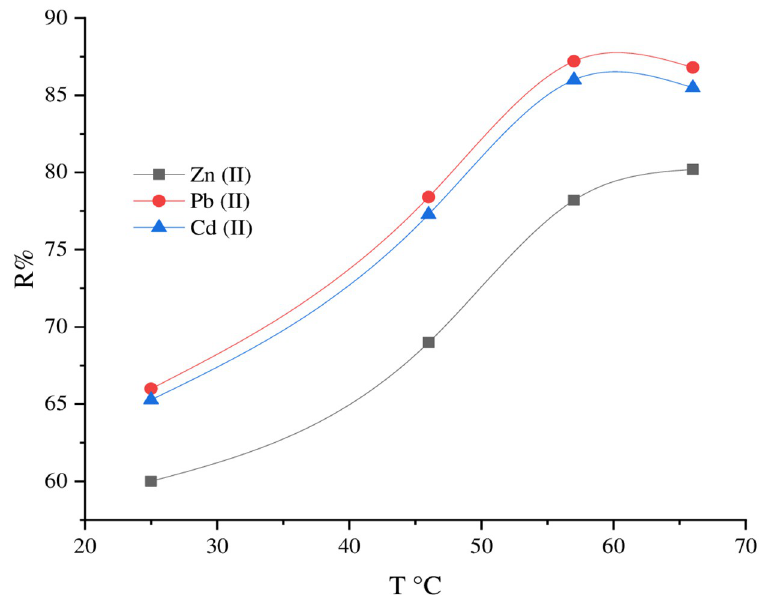
Fig 13. The Zn +2 , Pb +2 , and Cd +2 adsorption by the SnCaAl 2 O 3 nanoparticles under various temperatures (25– 66˚C), at constant adsorbent dose, contact time, optimum pH, initial concentration of ions, and volume of polluted